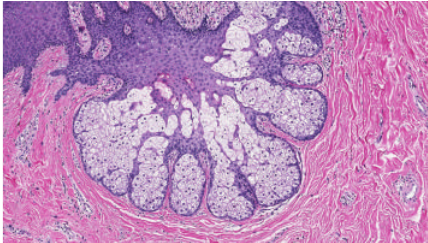
Figure 6: High power pathology slide (sebaceous gland with increase in surrounding smooth muscle